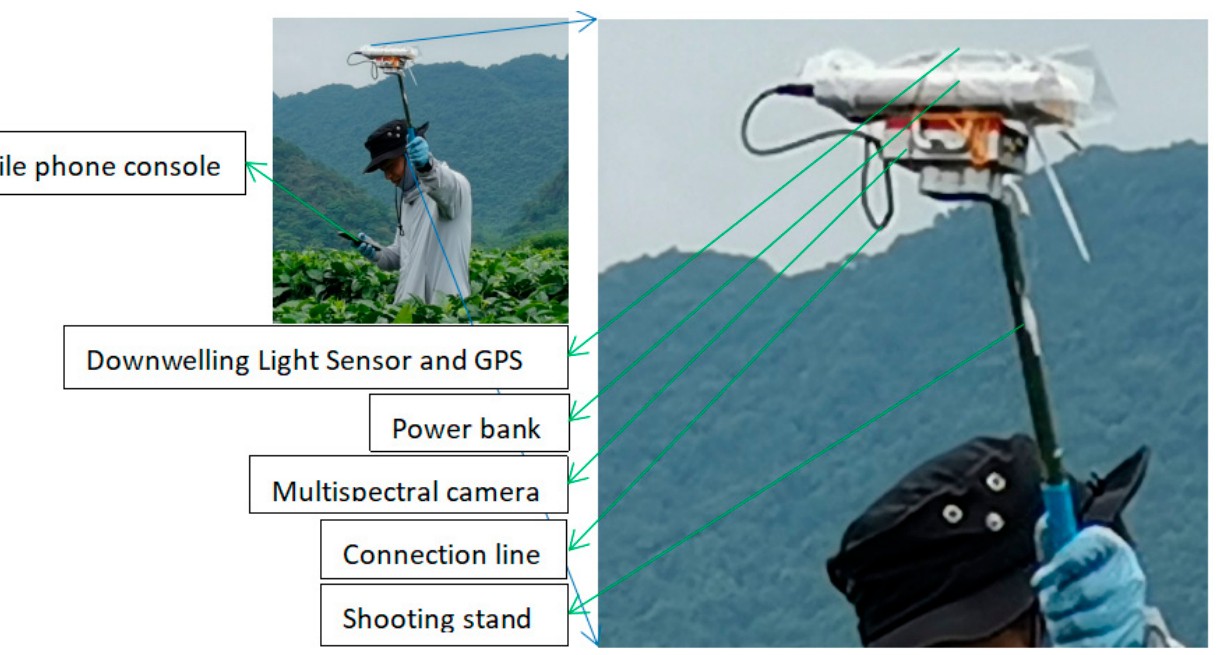
Table 1. Spectral parameters of multispectral sensor.